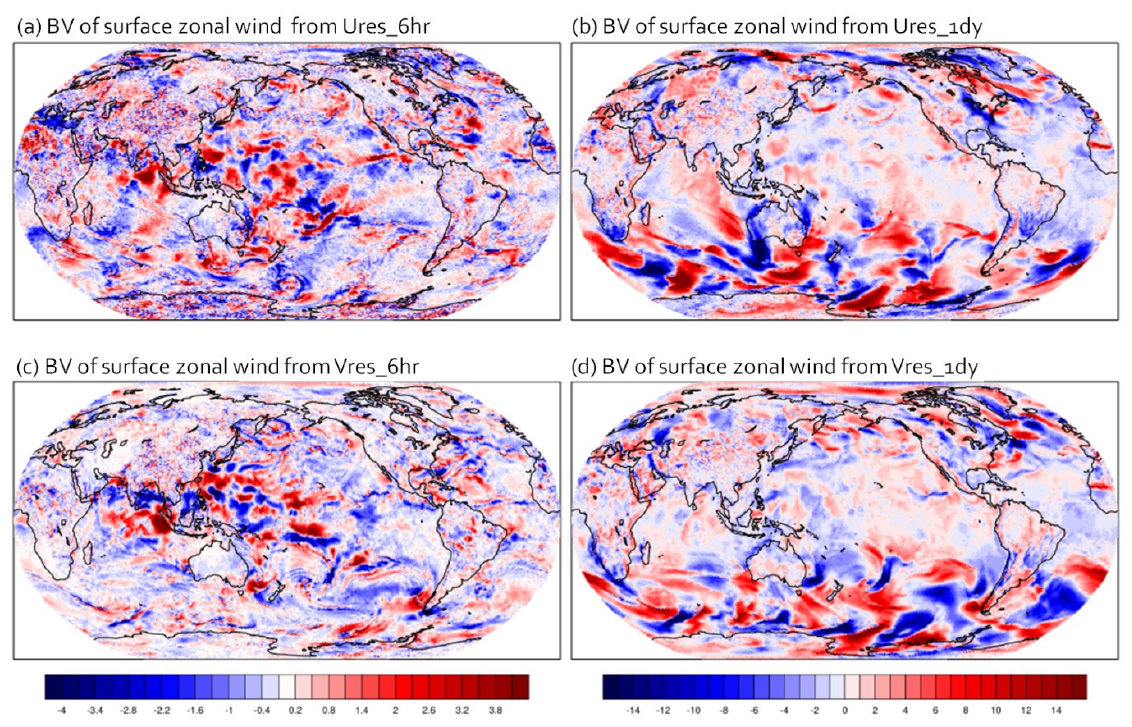
Figure 7. Same as Figure 6 except for the variable of surface zonal wind (m/s).